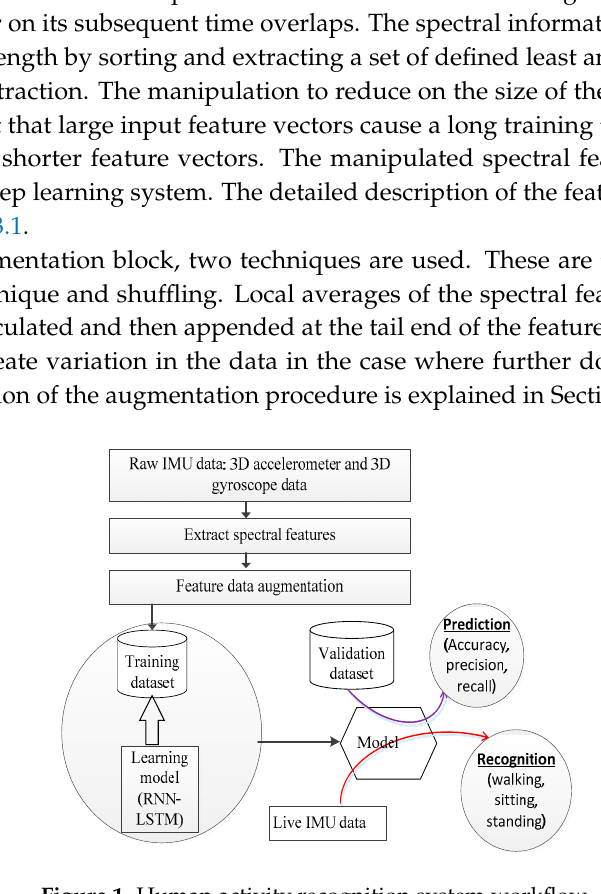
Figure 1. Human activity recognition system workflow.